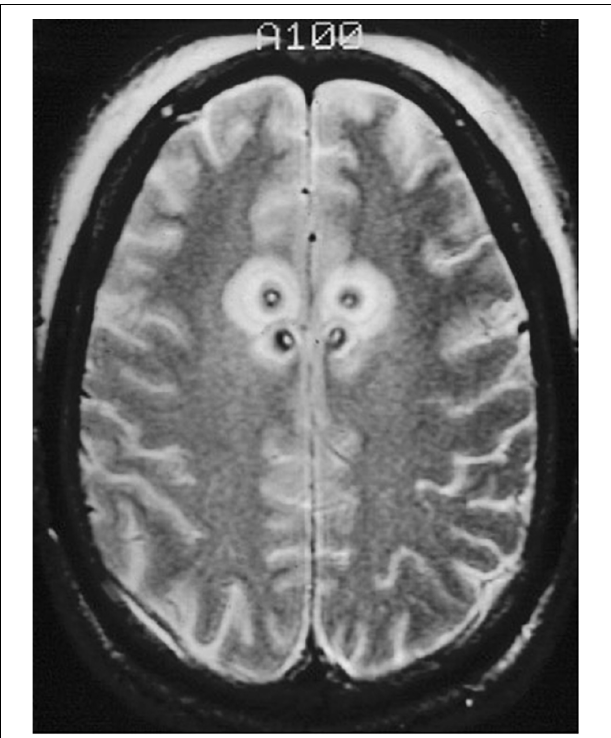
FIGURE 5 | Staged cingulotomy. Transverse T2-weighted MRI of chronic (posterior) and acute (anterior) double cingulotomy lesions.